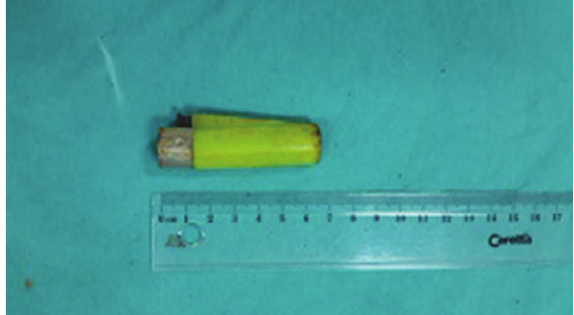
Figure 3: The lighter